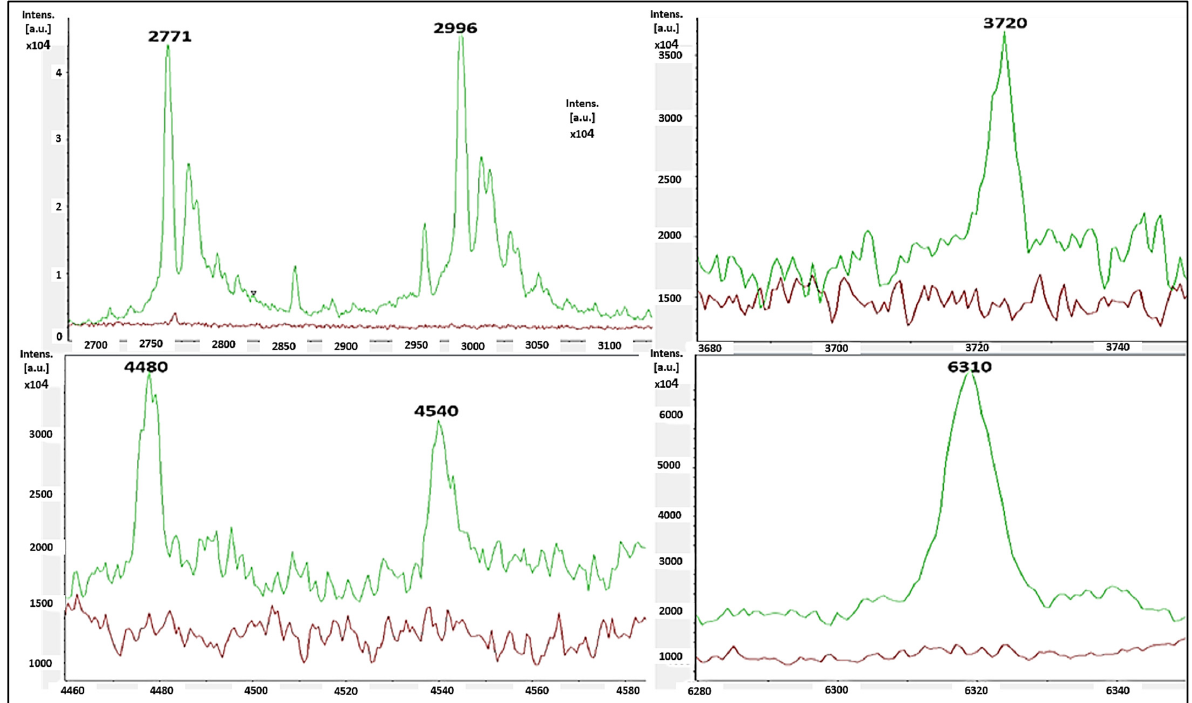
Figure 3. MSSA (green color) had single-peak intensities (2771 Da, 2996 Da, 3720 Da, 4480 Da, 4540 Da, and 6310 Da), whereas MRSA (red color) did not (red color).